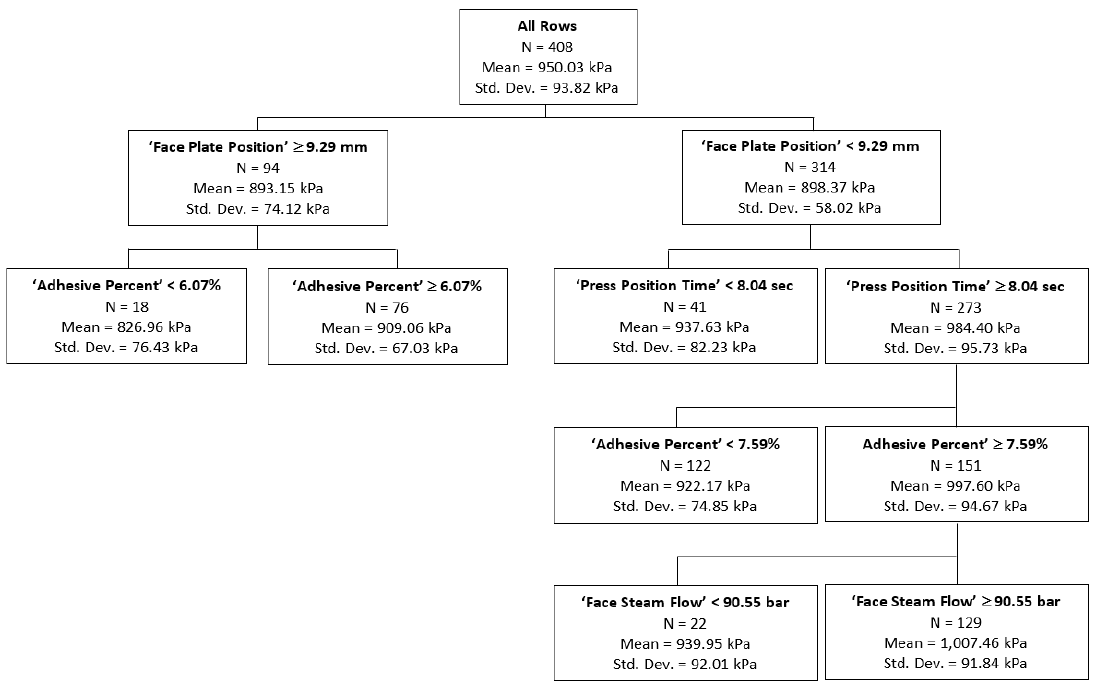
Figure 1. Regression tree for MDF tensile strength derived from boosted tree and random forest models. Table 5. Box–Behnken design for tensile strength ( n = 27) for 2 k , k = 4 with three center points based on the results of the RT for